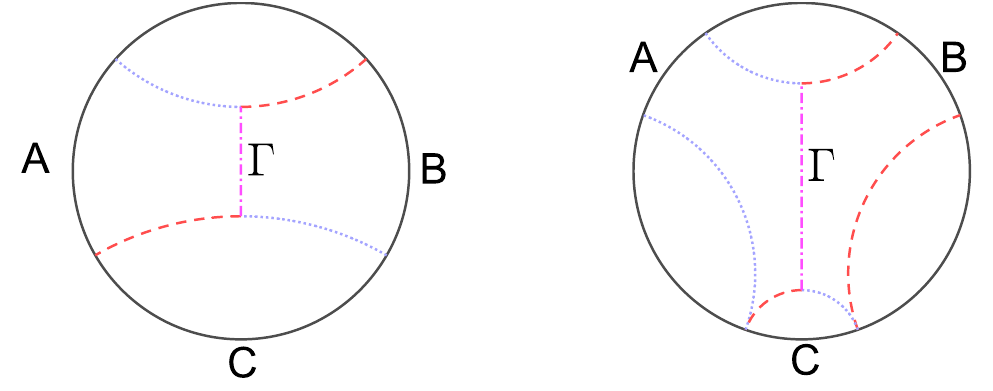
Figure 2 . Graphical proof of the upper bound on the conditional mutual information for both the case in which the regions A, B, and C are contiguous and the case in which they are disconnected. It is clear from the diagrams,and Ryu-Takayanagi, that the area of the dotted surfaces plus the area of the dash-dotted surface is greater than or equal S ( AC ) and that the area of the dashed surfaces plus the area of the dash-dotted surface is greater than or equal S ( BC ) : Adding these two inequalities gives us the desired